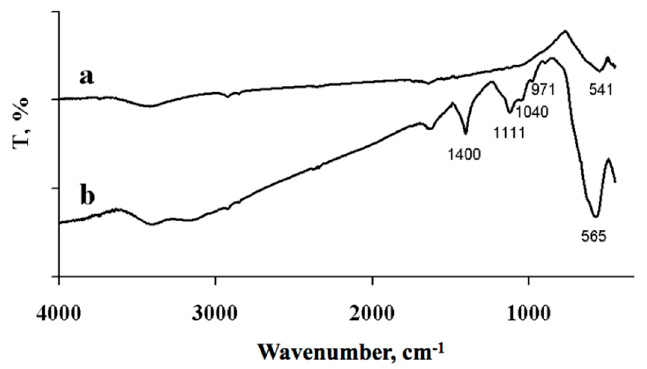
Figure 2. IR spectra of the synthesized powders α -Fe 2 O 3 ( a ) and Fe 3 O 4 ( b ).